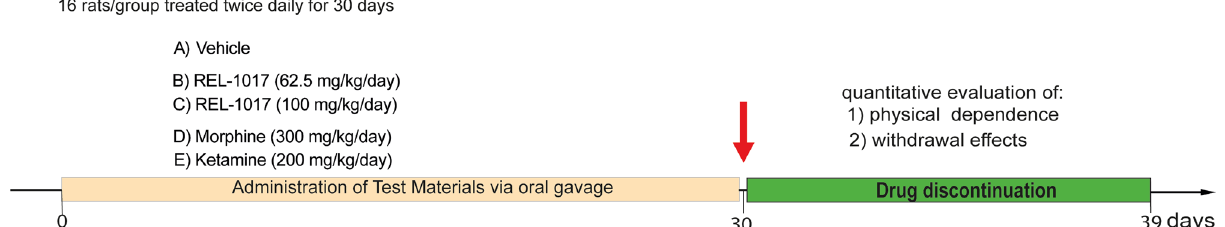
Figure 2. Chronic drug exposure and withdrawal study design (Study 2). All drugs (morphine, ketamine, REL-1017, and vehicle control) were administered daily by oral gavage for 30 consecutive days. In the afternoon of Day 30, all rats received vehicle (sham) doses as their last delivered dose on study to test for withdrawal over 9 consecutive days. A total of 96 rats were tested, 16 rats for each treatment group. During the 9 days of discontinuation to assess physical dependence and withdrawal effects, we assessed neurobehavioral screening battery consisting of a set of functional observational batteries (FOBs), which included measures of